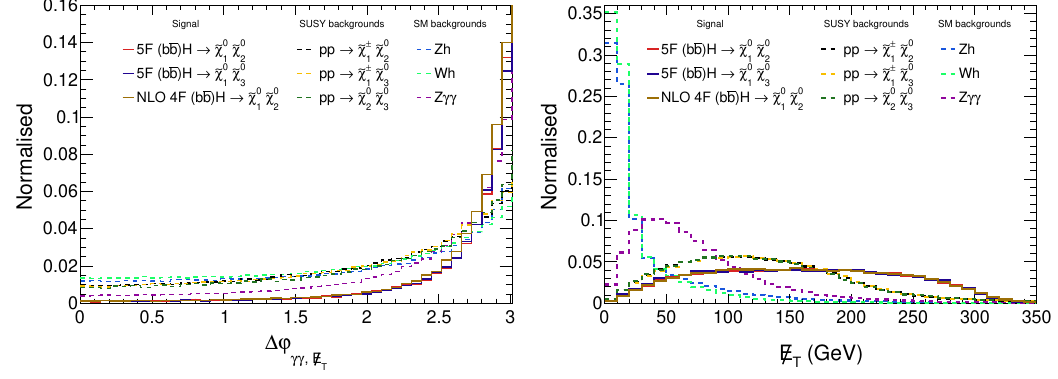
Figure 20. The normalised distributions of ∆ φ state after the basic trigger cuts.